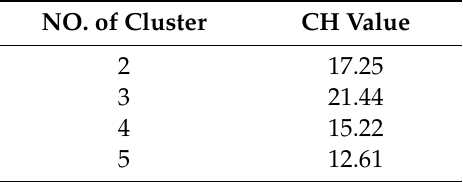
Table 7. Calinski–Harabasz (CH)